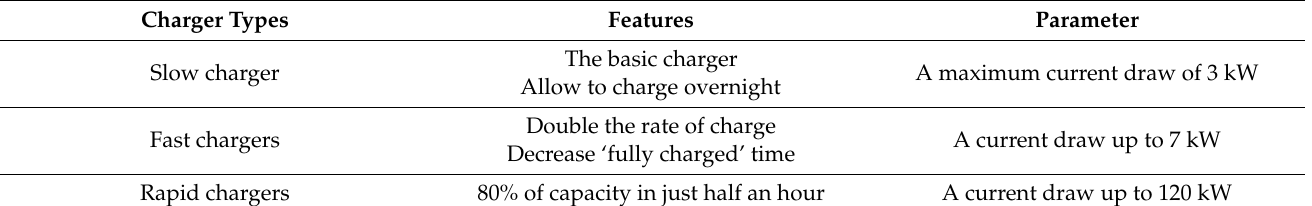
Table 8. Types of chargers [23] .